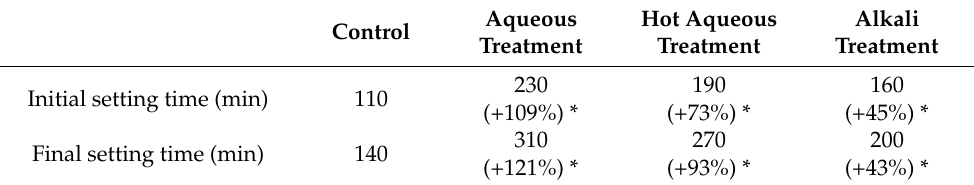
Table 4. Evolution of setting time with different treatments.